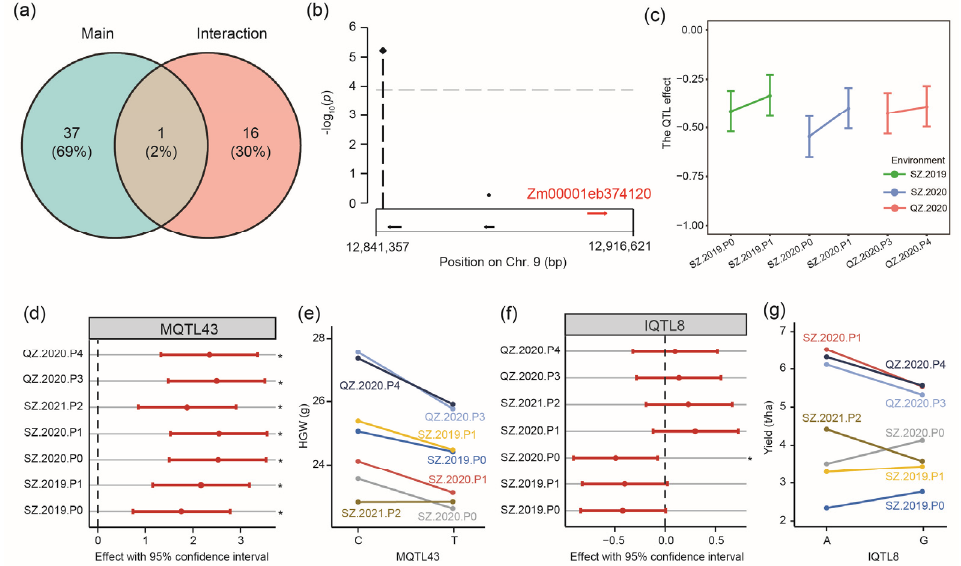
Figure 6. QTL mapping for main and locus-by-environment interactions. ( a ) Venn diagram of main QTL and G-by-E QTL for 15 traits. ( b ) Identification of the gene Zm00001eb374120 as main QTL MQTL38 (chromosome 9: 12.46–13.06 Mb) for ELW. ( c ) The effect of MQTL38 in paired environments. ( d ) Genotype × environment interaction effects (GGE)-type marker effect for main QTL MQTL43 (chromosome 9: 121.45–121.46 Mb) identified for hundred-grain weight (HGW). ( e ) Mean HGW of the two QTL alleles in the seven environments. ( f ) GGE-type marker effect for the interaction QTL IQTL8 (chromosome 2: ~214.58 Mb) identified for yield and ( g ) mean yield distribution of the two QTL alleles in the seven environments. The significance of GGE-type effects was tested by the Wald test, * means the effect is significant at the level of 0.05.